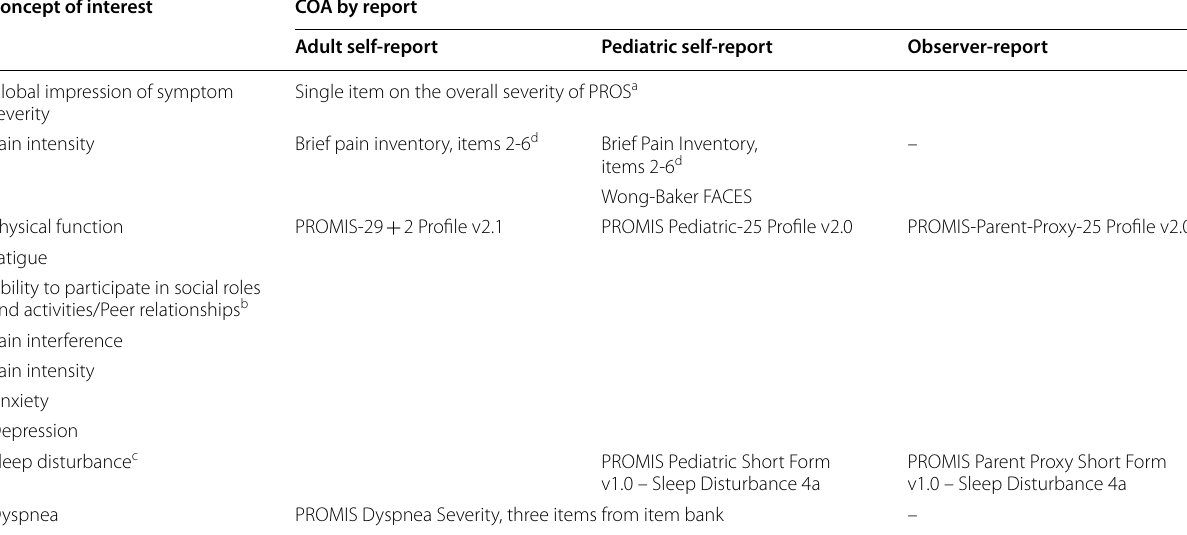
Table 2 List of COAs included in cognitive debriefing